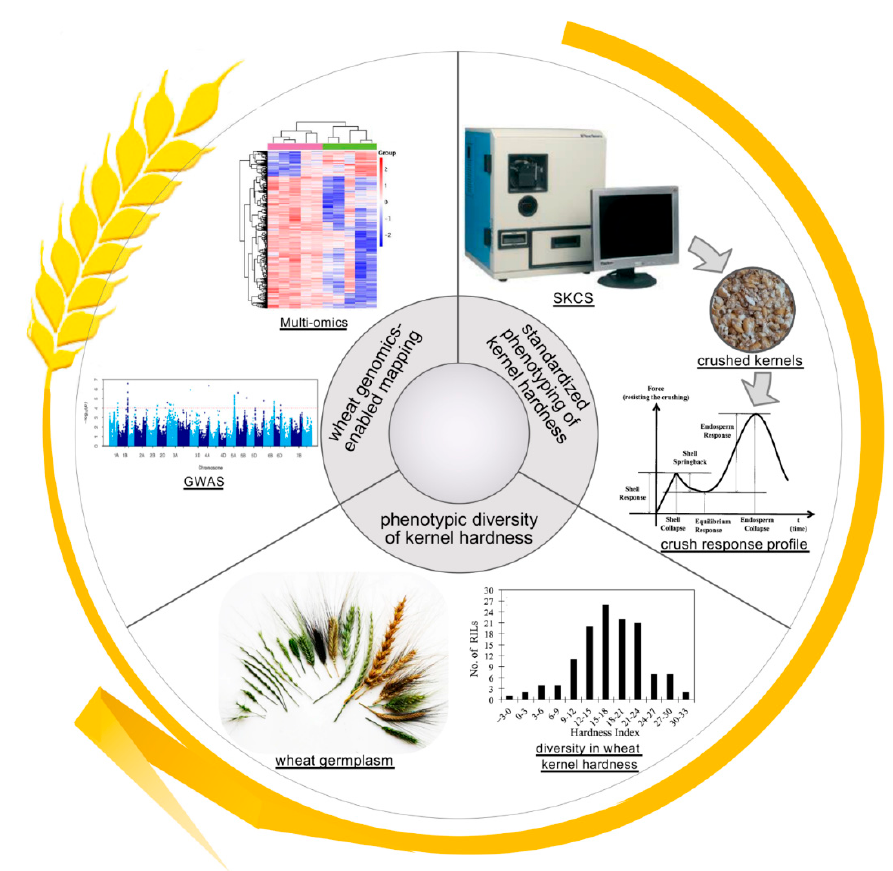
Figure 2. Advancement in phenotyping, germplasm and genotyping technologies has facilitated our understanding of the genetic basis of kernel hardness in wheat. An essential first step toward unveiling the genetic basis and multiple QTLs of kernel hardness is to establish a robust phenotyping method. SKCS provides a standardized measurement of kernel hardness and considers interfering factors, including kernel weight, diameter and water content, and individual variations between kernels. Secondly, appropriate germplasm or mapping populations are required to identify the multiple QTLs associated with wheat kernel hardness, because the Ha locus on chr. 5DS plays a major role in kernel hardness and could complicate the detection of other minor QTLs. Subsequently, recent advancements in wheat genomics and population genetics have provided the tools and resources for high-resolution phenotype–genotype association: (1) a large number of SNPs is necessary for high- density linkage mapping or association analysis; (2) a contiguous, high-quality reference genome of wheat is necessary for linkage mapping, GWAS analysis and candidate gene identification; (3) multi- omics data on wheat are increasingly accumulating, providing additional resources for narrowing down and prioritizing candidate genes of kernel hardness.